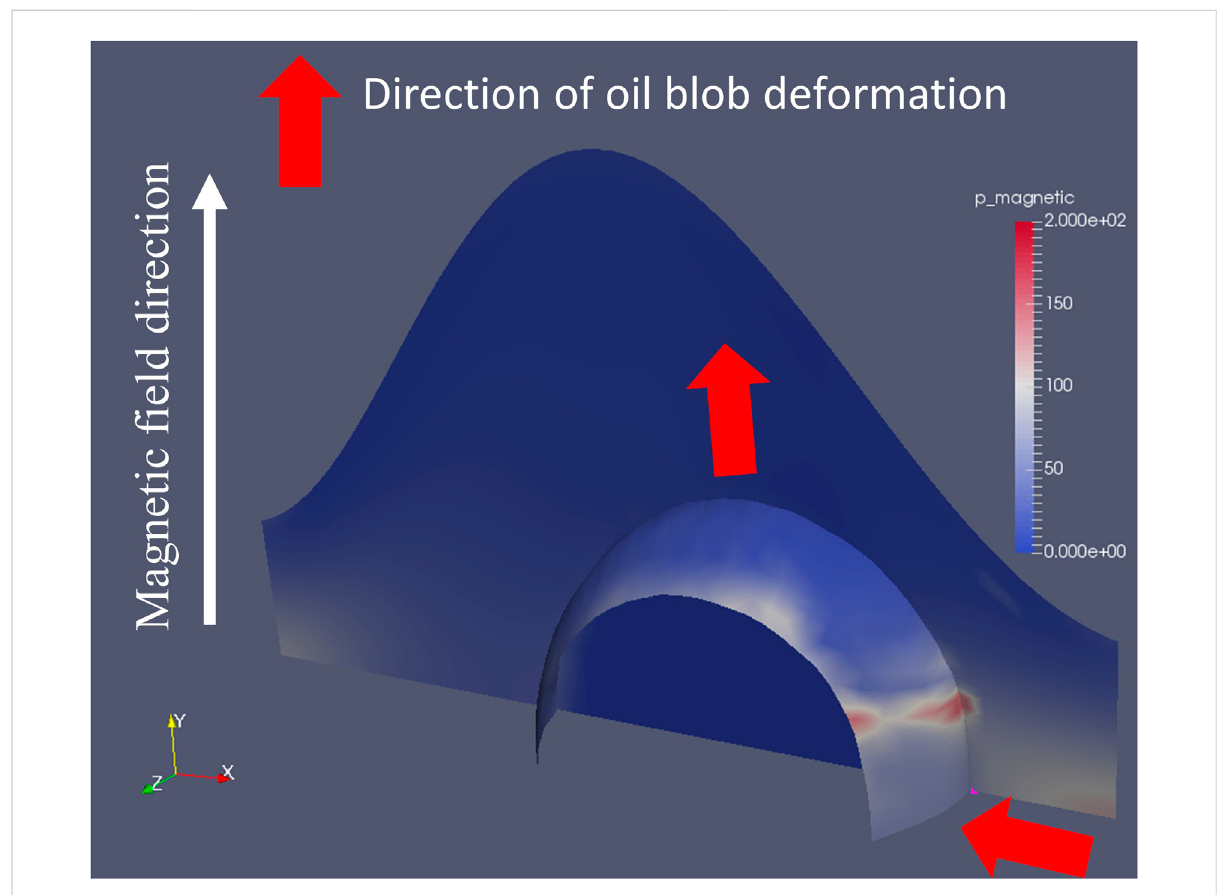
FIGURE 14 Magnetic-induced pressure in the pore near the oil blob in a ferro fl uid fl ooding. The magnetic fi eld is transverse to the fl ow direction. The pressure is plotted in a cross section (the plane) in the pore and at the oil/ferro fl uid interface (the curved surface). The higher magnetic-induced pressure at the throat pushes the oil blob away from the throat, making it harder to mobilize the oil blob (based on Wang et al.,